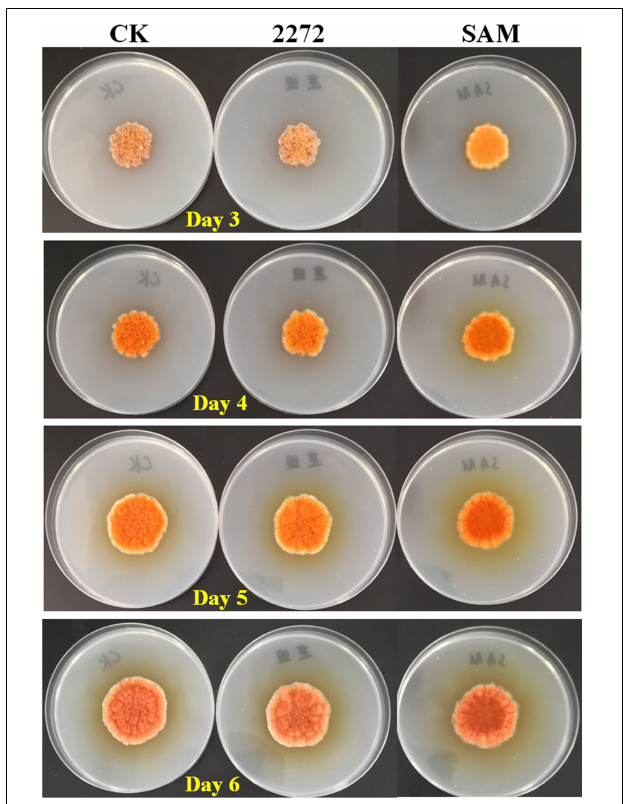
FIGURE 4 | Cultivation of M. purpureus RP2 and M. purpureus 2272 in fermentation agar plates. CK, M. purpureus RP2 fermentation without addition of amino acid; 2272, M. purpureus 2272 fermentation without addition of amino acid; SAM, M. purpureus RP2 fermentation with addition of 1 g/L